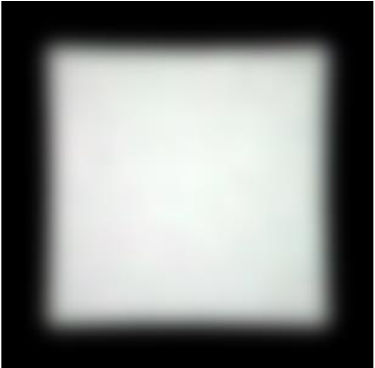
Figure 7. The pattern of color mixing on the target plane.